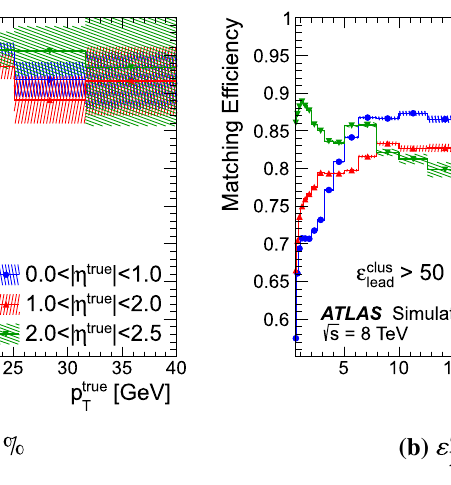
matched topo-cluster the procedure is less likely to be run. The data are taken from a dijet sample without pile-up with 20 < p lead and the statistical uncertainties on the number of MC simulated events are shown as a hatched